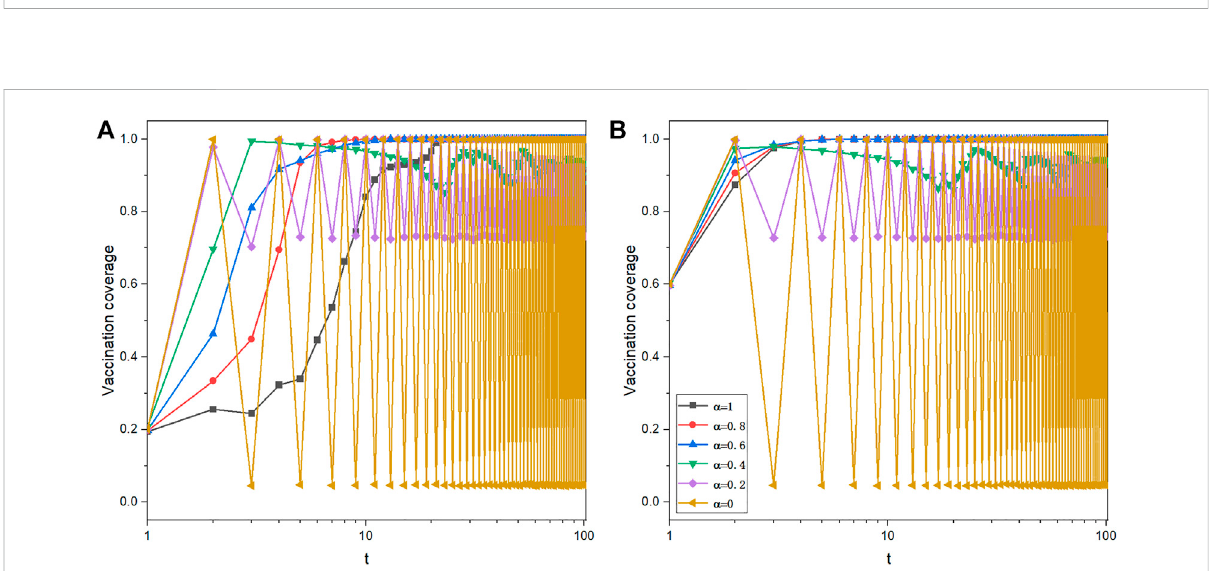
FIGURE 9 Time courses of vaccination coverage when the population adopts the myopic strategy updating rule. V 0 = 0.2 (A) and V 0 = 0.6 (B) . Depicted results are obtained for γ = 0.8, K = 0.1, C V = 0.3, and C H =